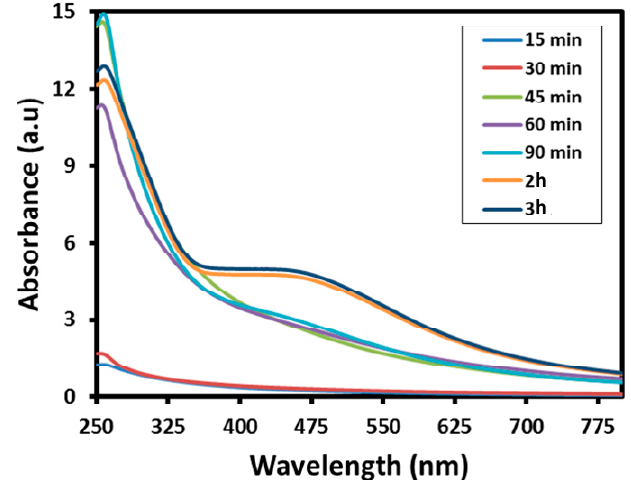
Figure 3. Kinetic reaction study of the (UV-Vis) absorption spectra of the silver nanoparticles (SP-Ag-3) during the synthesis at various time intervals.